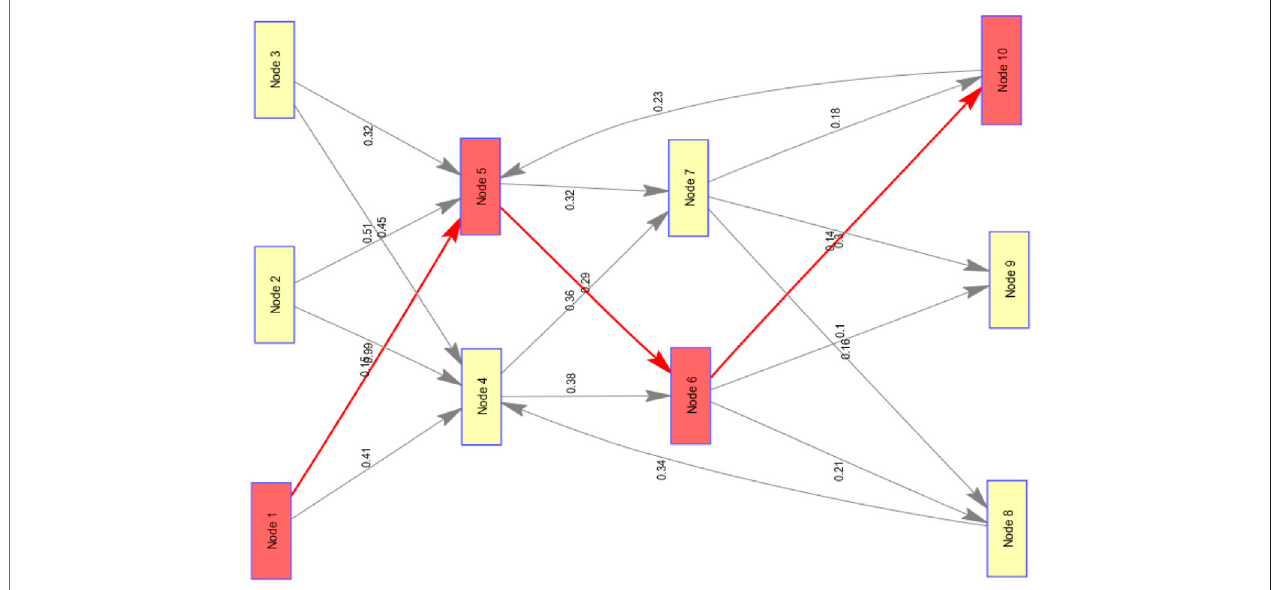
FIGURE 5 | Sra algorithm response and network connection.